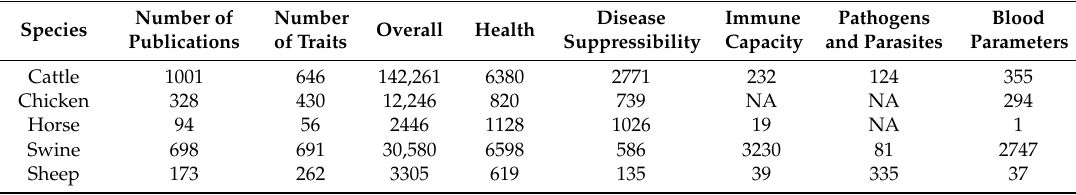
Table 3. The number of quantitative trait loci (QTLs) detected in animal species by 7 July 2020. Number of Number Species Overall Health Publications of Traits